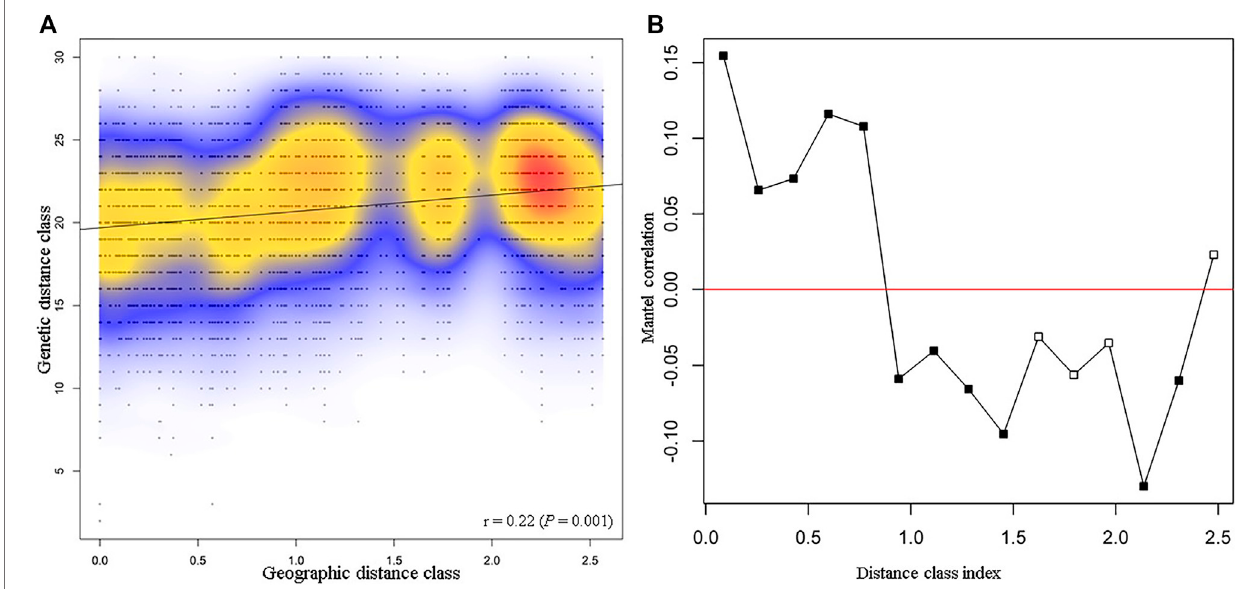
FIGURE 2 | Mantel test results from the Pyrus calleryana dataset. Mantel test (A) and Mantel isolation-by-distance correlogram (B) for samples included within the P. calleryana dataset using 1,000 permutations. Distance class index (in 100 s of km) represents the maximum linear distance between samples, i.e., 260 km. Correlograms in (B) marked with solid black symbols are signi fi cant at α = 0.05.